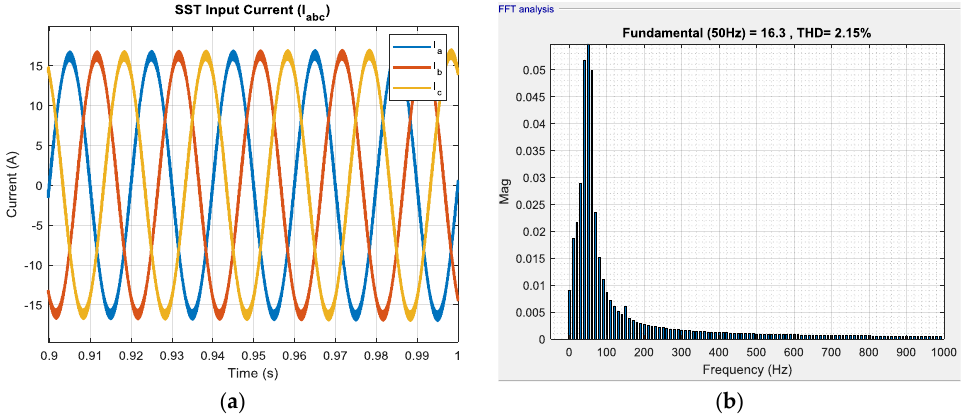
Figure 16. ( a ) SST input current at the grid side. ( b ) THD analysis of phase A input current. The voltage and current response of SST-VSC at DC -link , DC mes V with unbalanced loading is given in Figure 17.